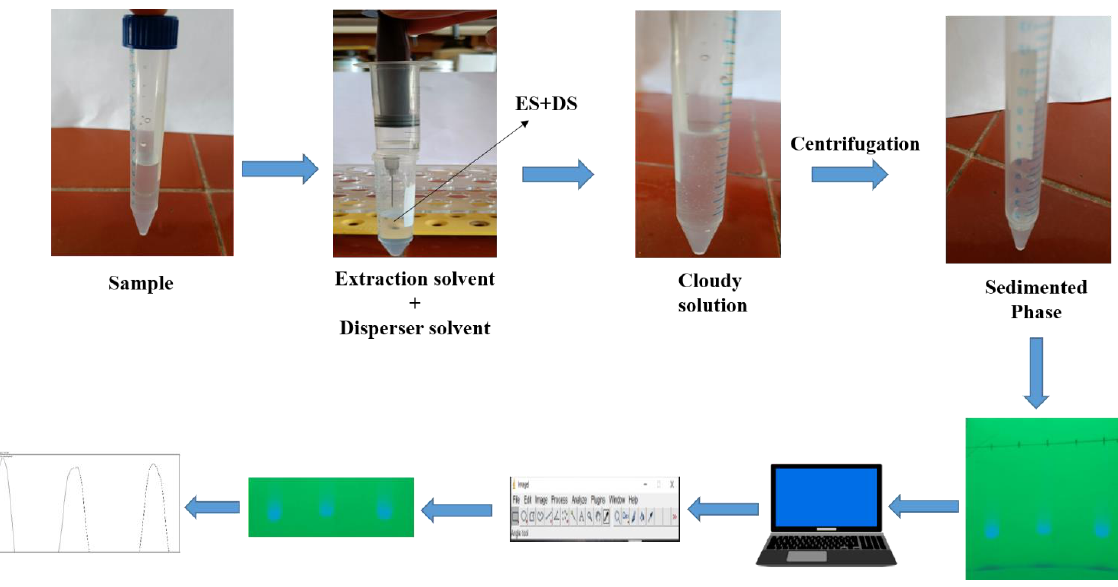
Figure 7. Systematic procedure of SA-DLLME-TLC-DIC for the determination of